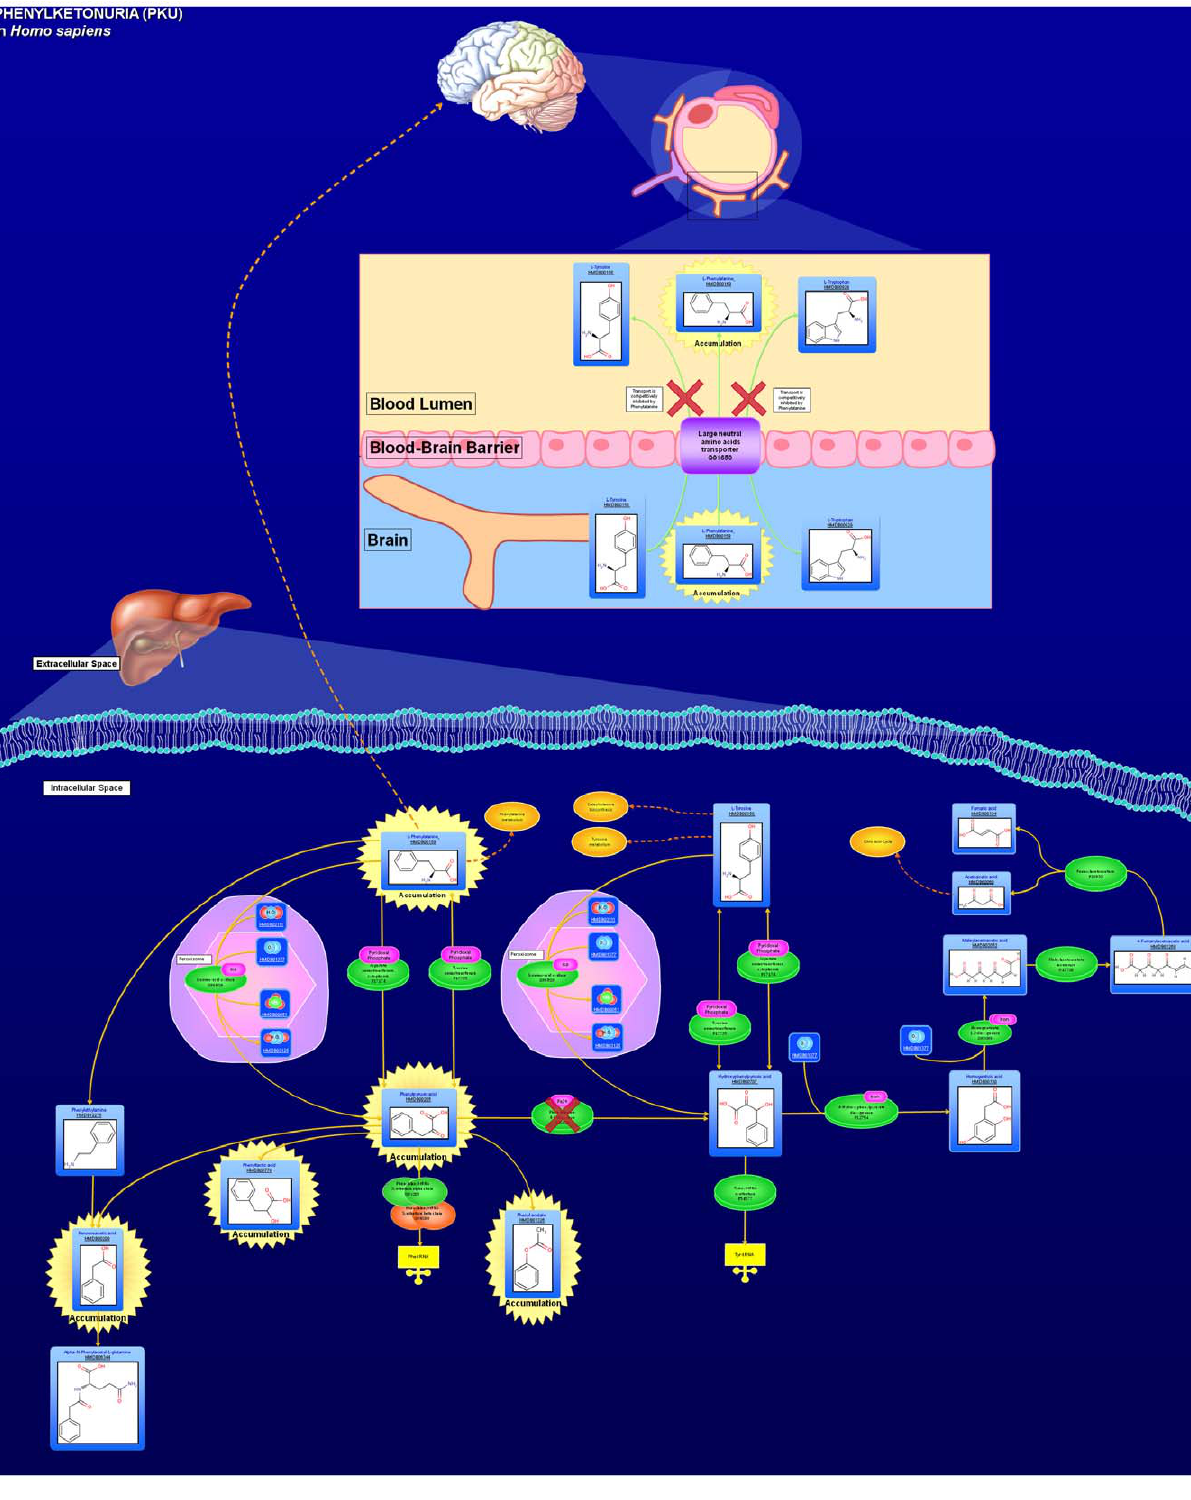
Figure 1. A pathway diagram for Phenylketonuria as taken from SMPDB (http://www.smpdb.ca).